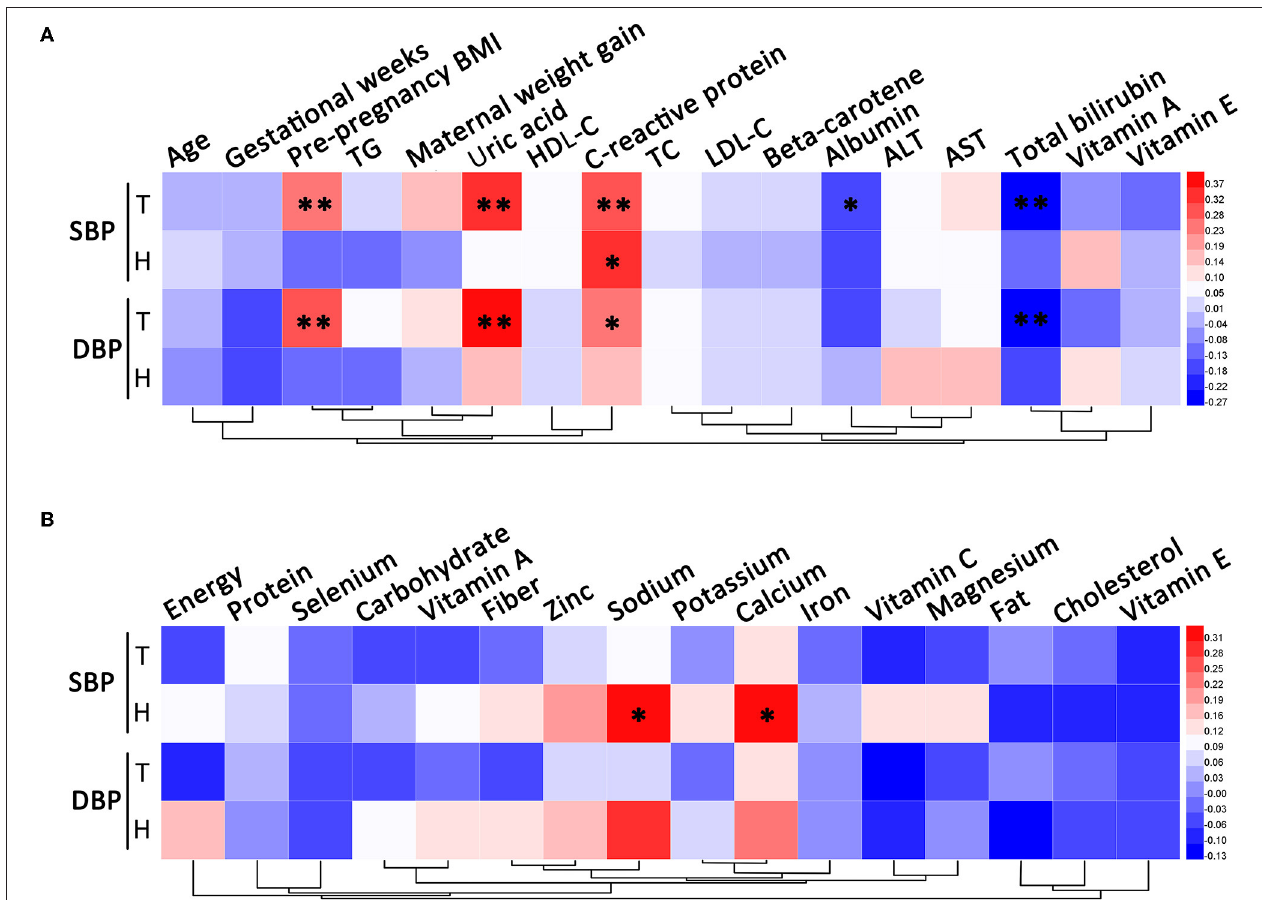
FIGURE 1 | Correlation analysis of blood pressure. (A) The correlations between blood pressure and clinical characteristics. (B) The correlations between blood pressure and dietary nutrient intakes. T, total; H, HDP. * P < 0.05, ** P < 0.01.